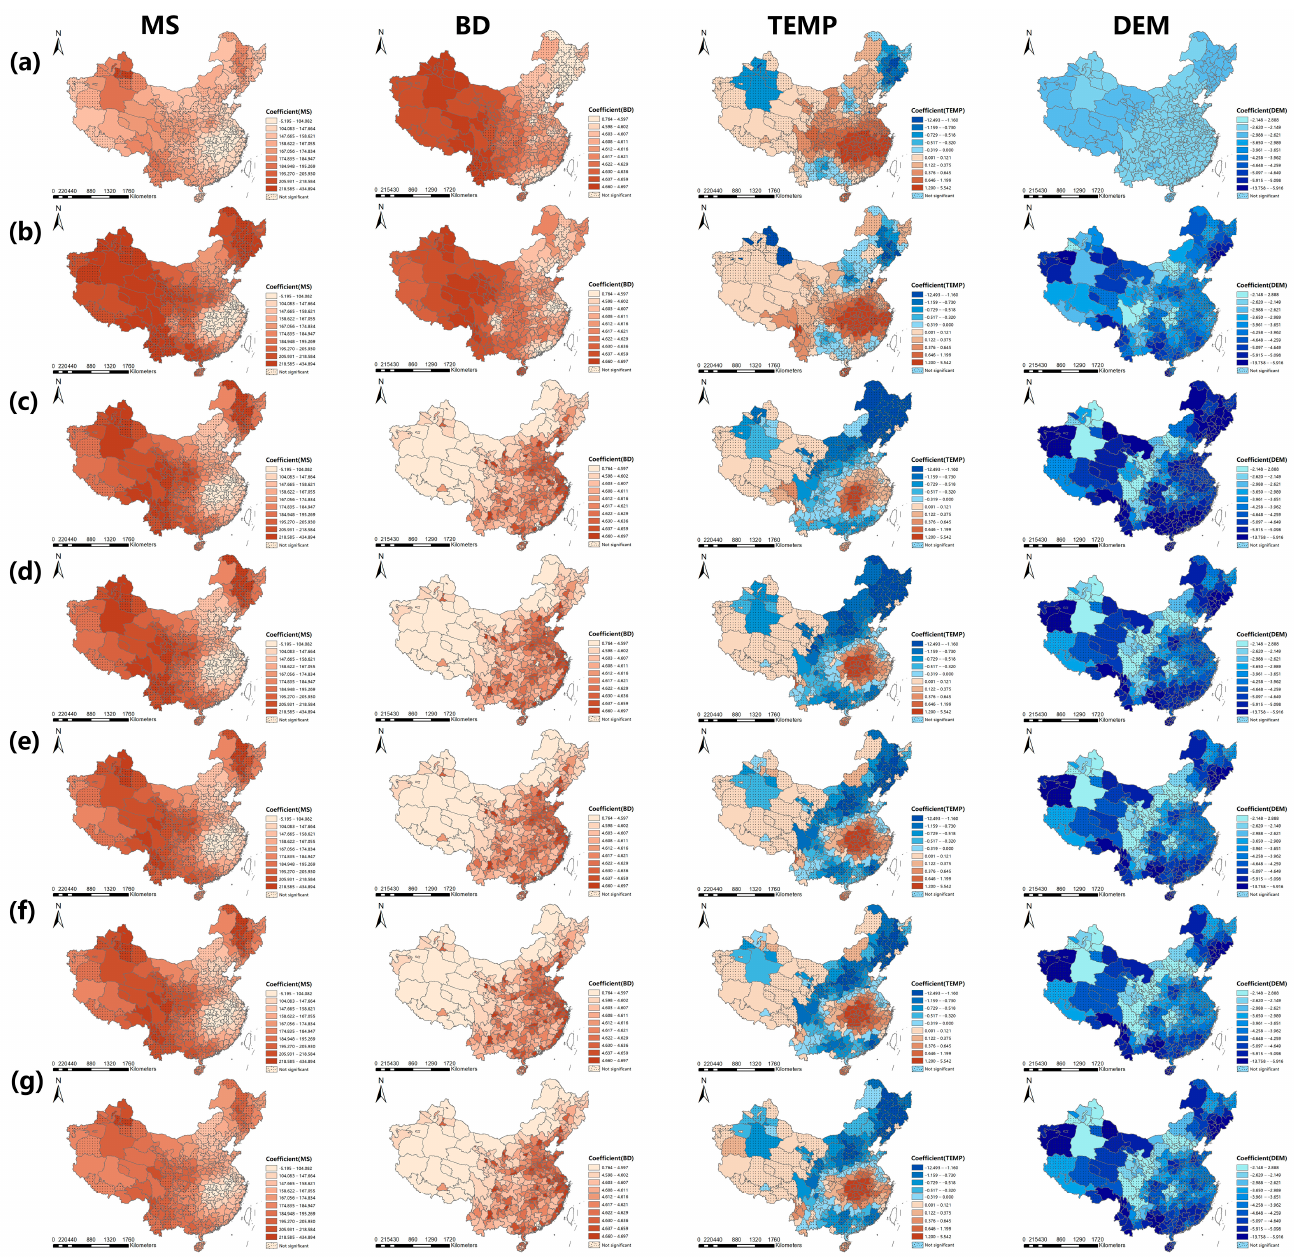
Figure 5. ESF-SVC spatially varying coefficient maps of health risk factors in mainland China, each column represents a risk factor (MS, BD, TEMP, DEM) and each line ( a – g ) represents a week